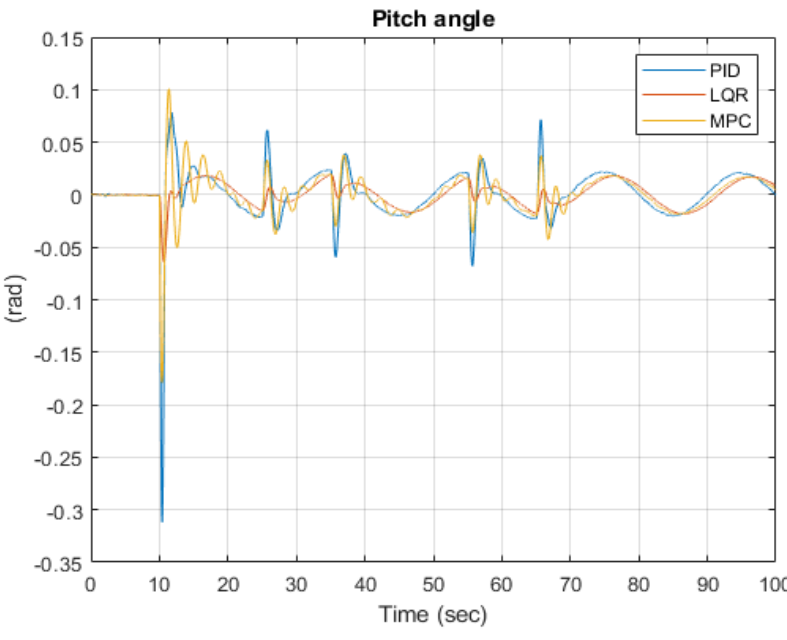
Figure 8. Performance of the controllers in pitch angle in simulation.